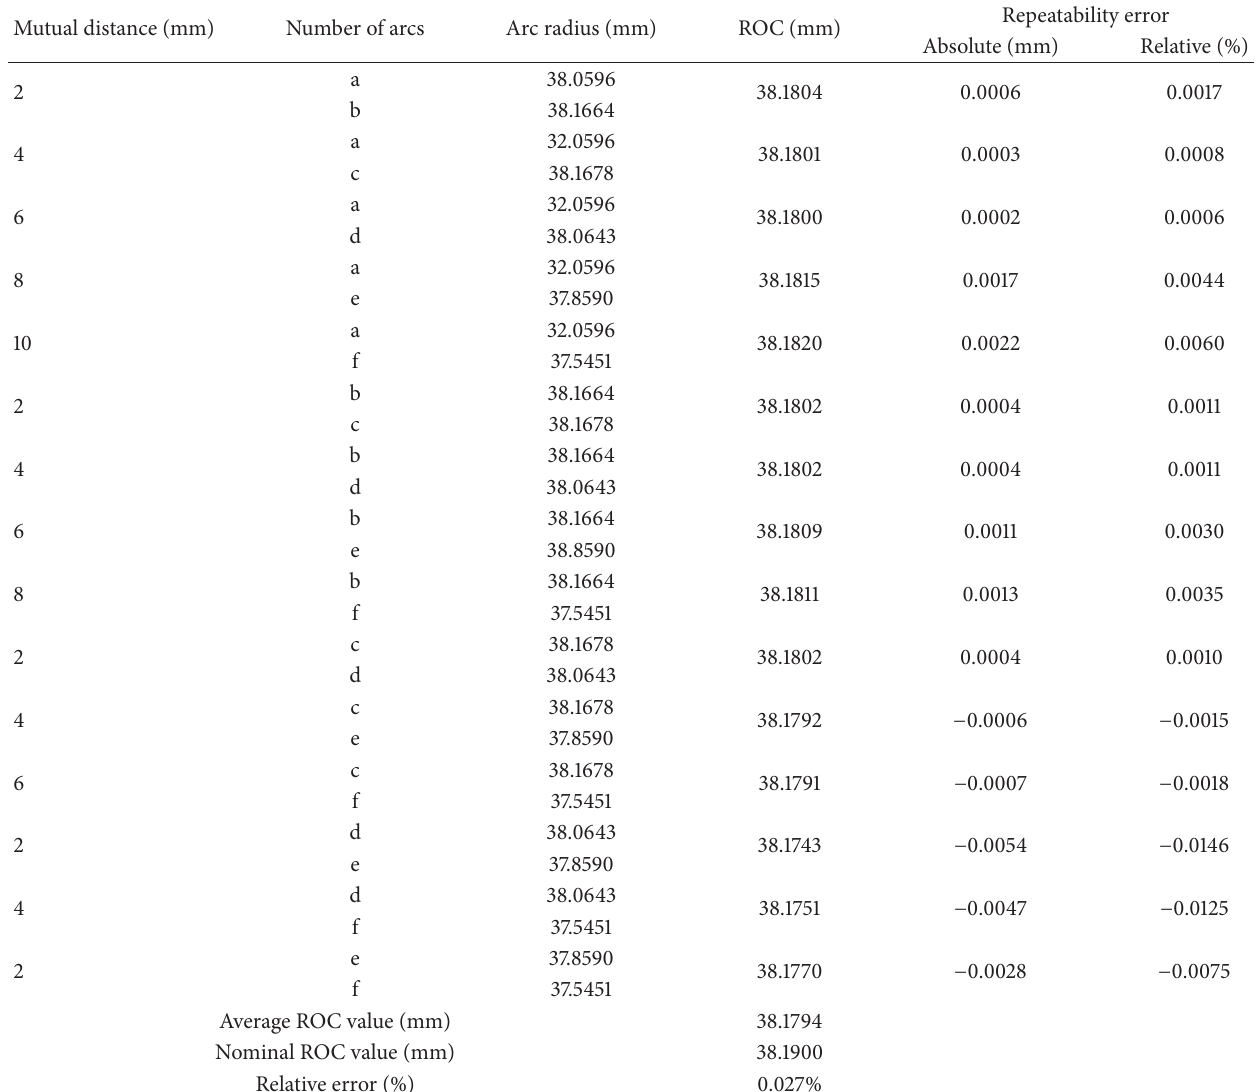
Table 1: Measurement results for a plane-convex